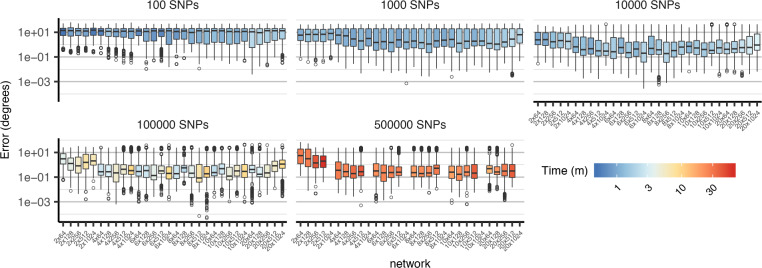
Comparison of cross-validation performance on the ag1000g dataset using SNPs from chromosome 3R, under varying network architectures and numbers of SNPs.Boxplots show the distribution of Euclidean distance between the true and predicted locations of validation samples across 10 replicate training runs. Network shapes are described on the horizontal axis as 'layers × width’. Although two-layer networks are typically the least accurate, no single architecture provides consistently better performance across datasets of different sizes. Missing networks required over 12 GB GPU RAM.